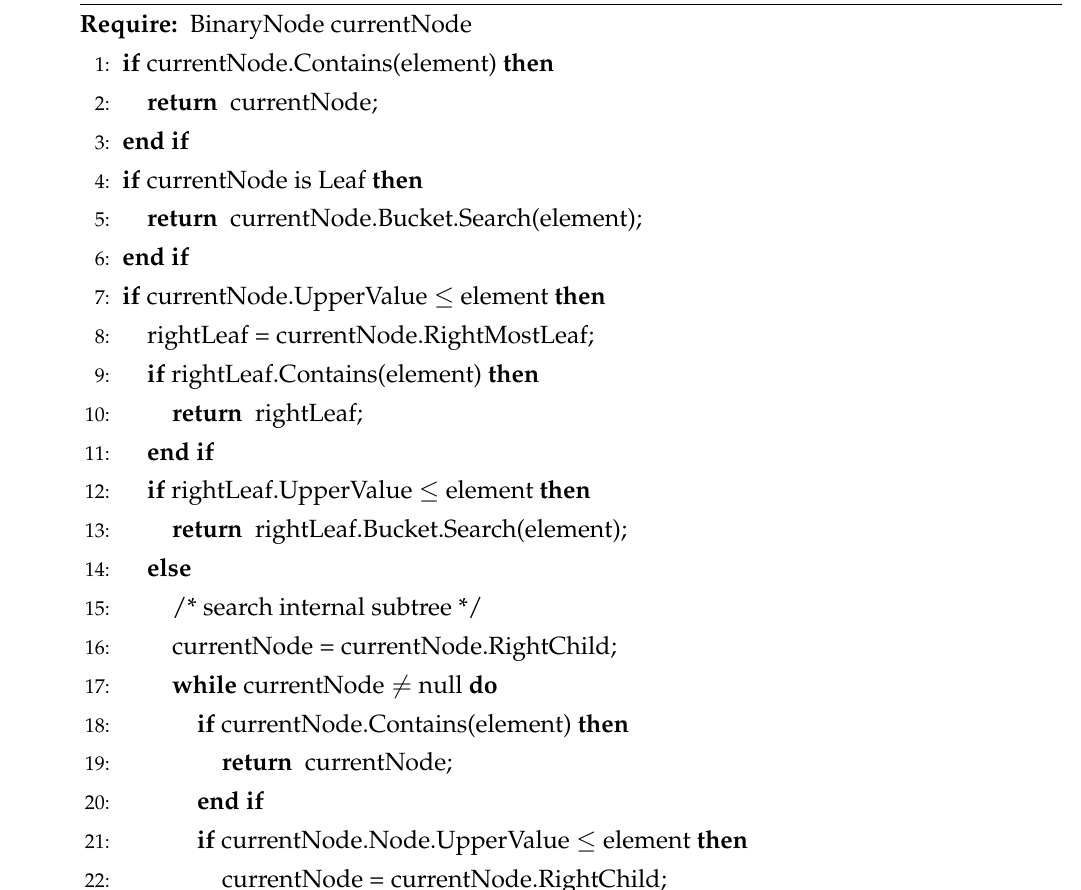
Algorithm 10 Search(SearchSubtree(integer